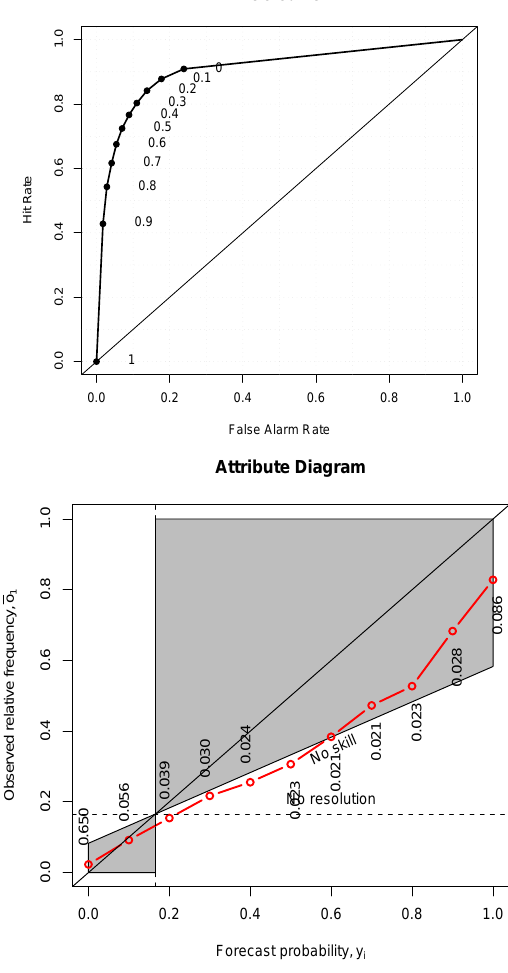
Fig. 5. (a) ROC Curve precipitation; (b) Attribute diagram, over 5mm/24h